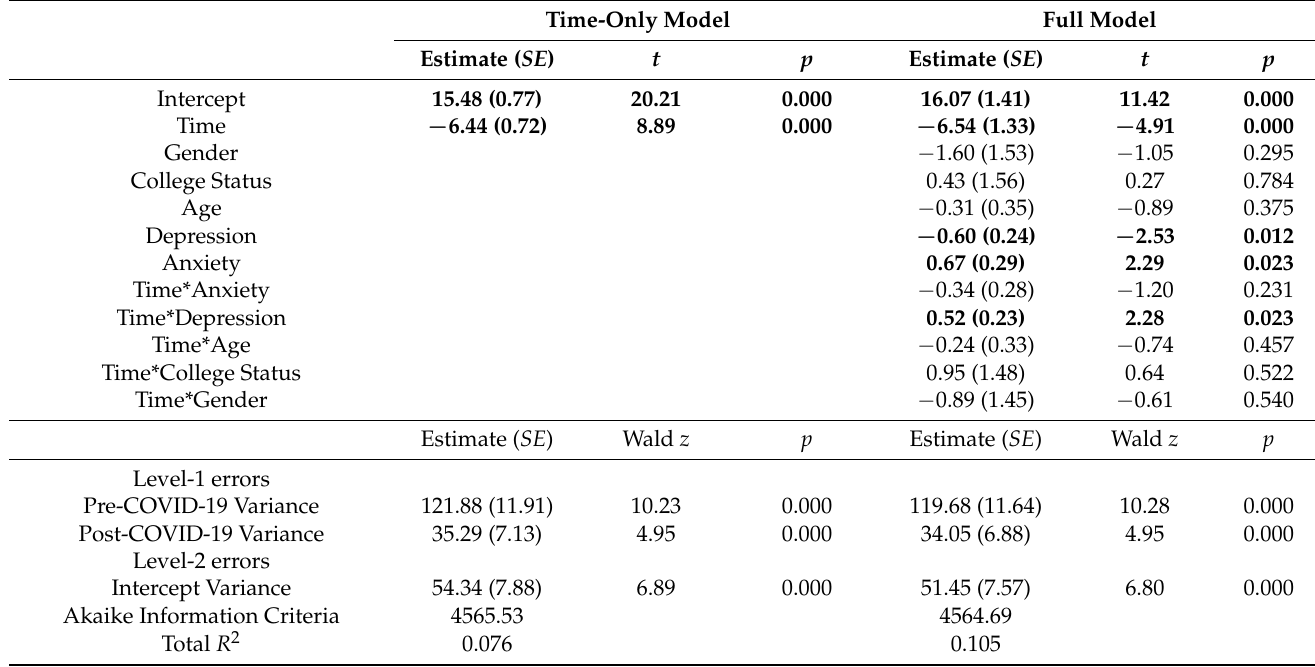
Table 3. Linear mixed models for drinking quantity outcome. Time-Only